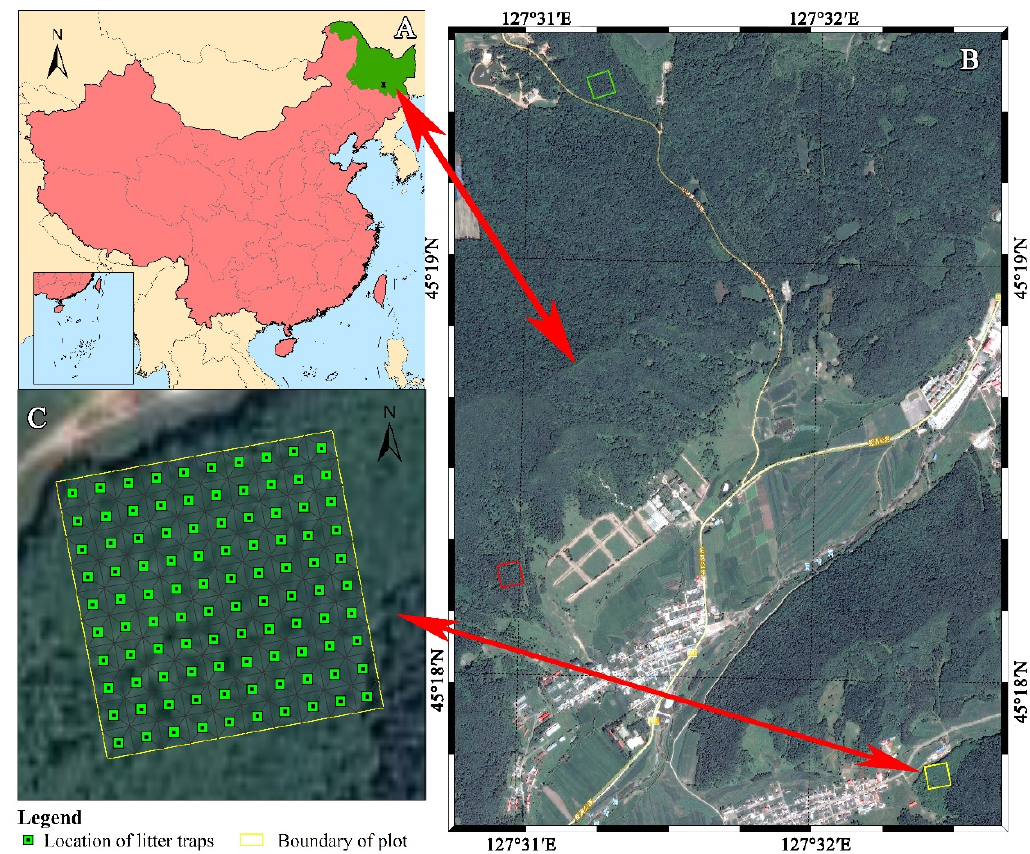
Figure 1. Study area map and LAI-2200 measurement points, TRAC transects, and leaf litter collection measurement points. (( A ) was the overview of the research regeion; ( B ) was the overview of the plots; ( C ) was the positions of the measurements. Note: in ( B ), the yellow rectangle is the broadleaf forest, the red rectangle is the coniferous forest, and the green rectangle is the mixed forest).